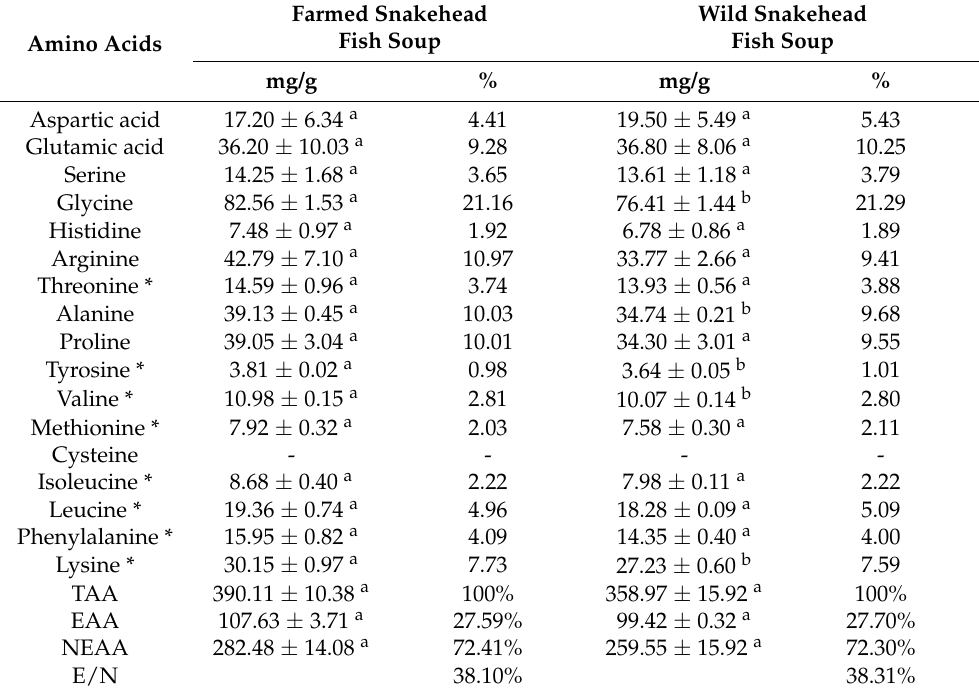
Table 2. Amino acid composition of soup made from farmed and wild snakehead fish.